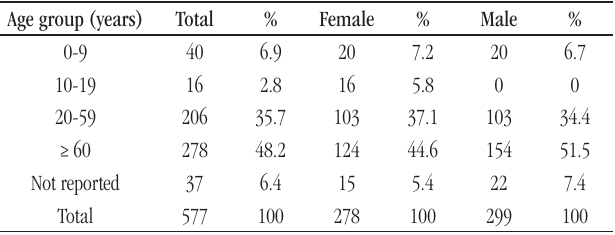
taBLE 2 − Age group by sex of positive samples between 2010 and 2015